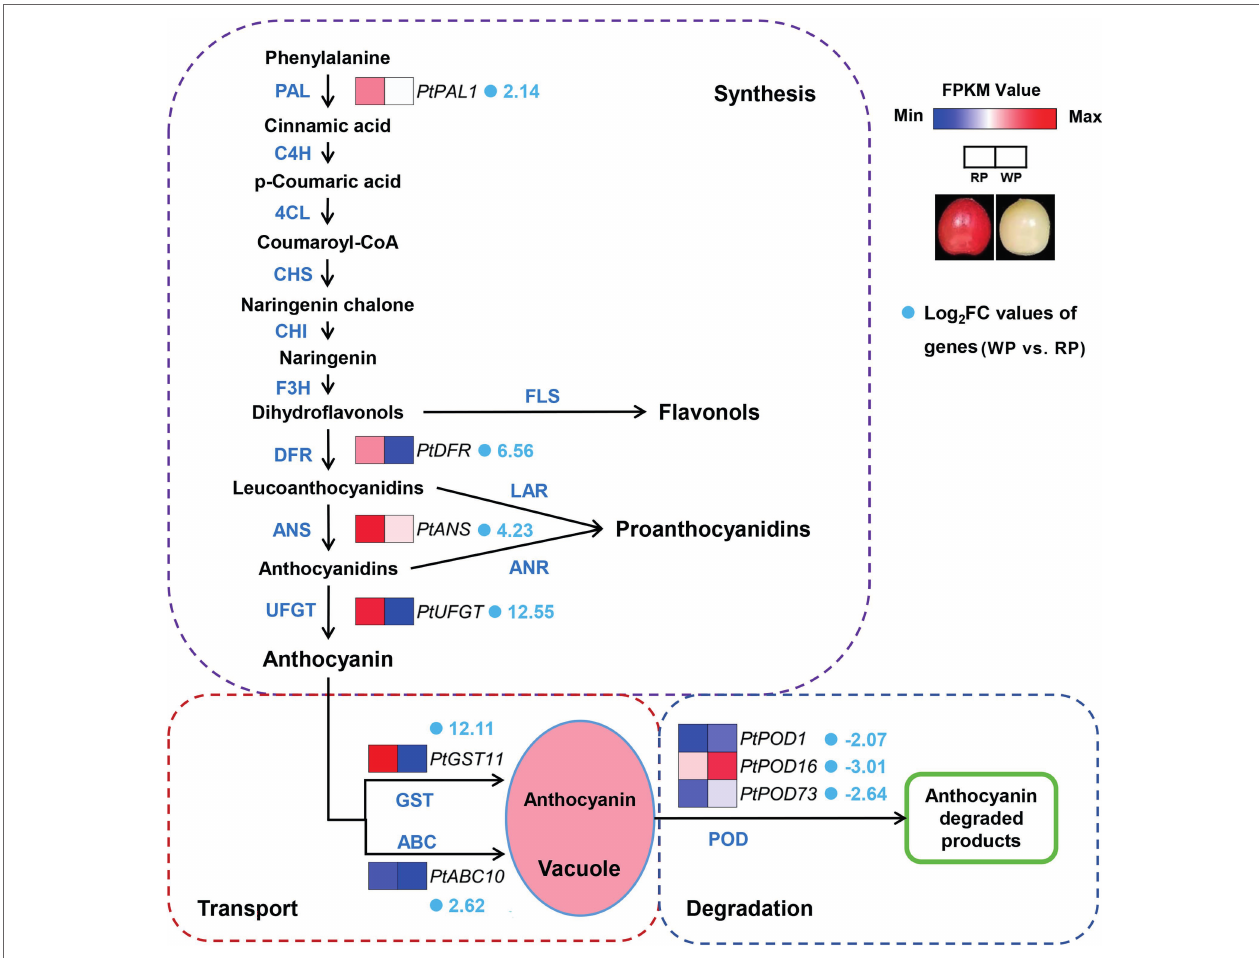
FIGURE 5 | Expression pattern of the candidate key significant DEGs involved in anthocyanin synthesis, transport, and degradation pathways in Prunus tomentosa . The color scale from blue to red represents the FPKM values from low to high. The fold number behind gene names represents the log 2 Fold Change values of genes (WP vs.